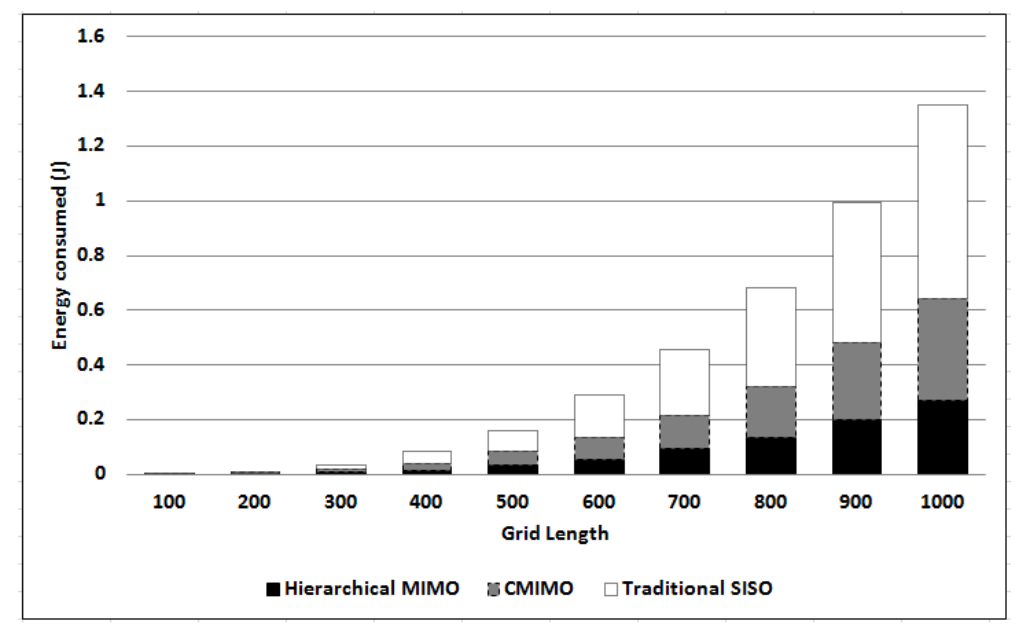
Figure 5. Energy (J) consumption per